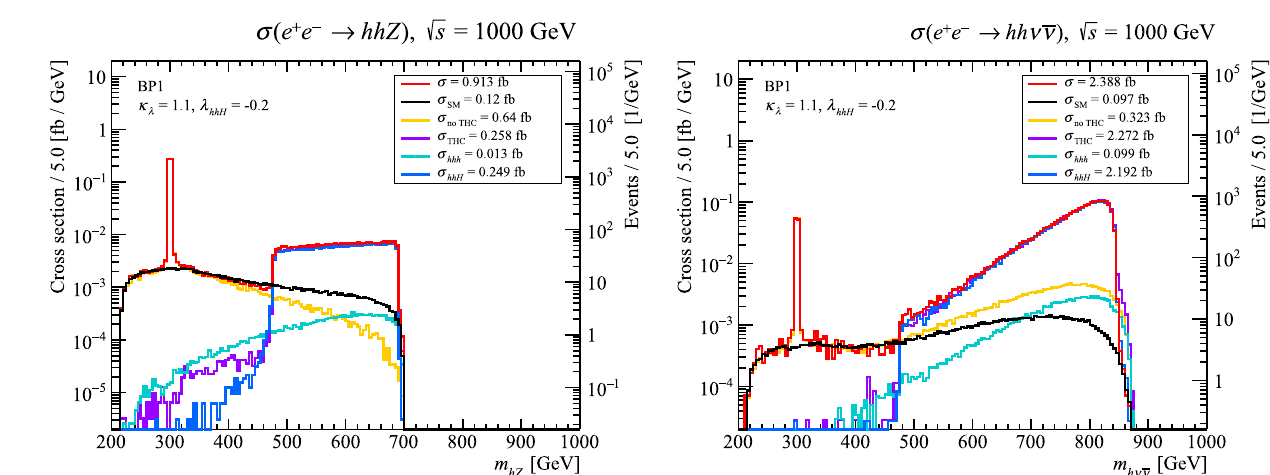
Fig. 24 Distribution on the invariant mass of the final hZ pair in the process e + e − → hhZ (left) and distribution on the invariant mass of the final h ν ¯ ν system in the process e + e − → hh ν ¯ ν (right) at